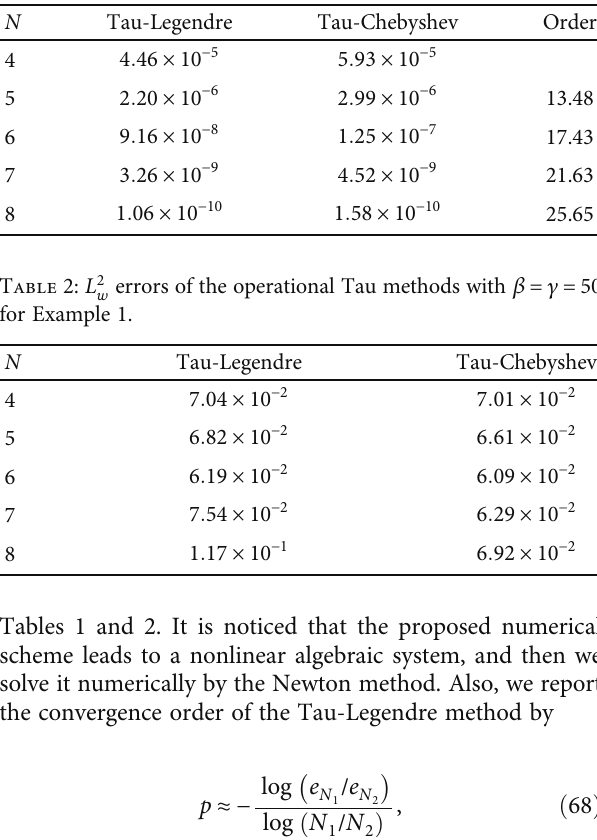
Figure 1: The plots of exact solution u ð t Þ = β te − γ t for β = γ = 1 and β = γ = 50 . Table 1: L 2 w errors of the operational Tau methods with for Example 1.